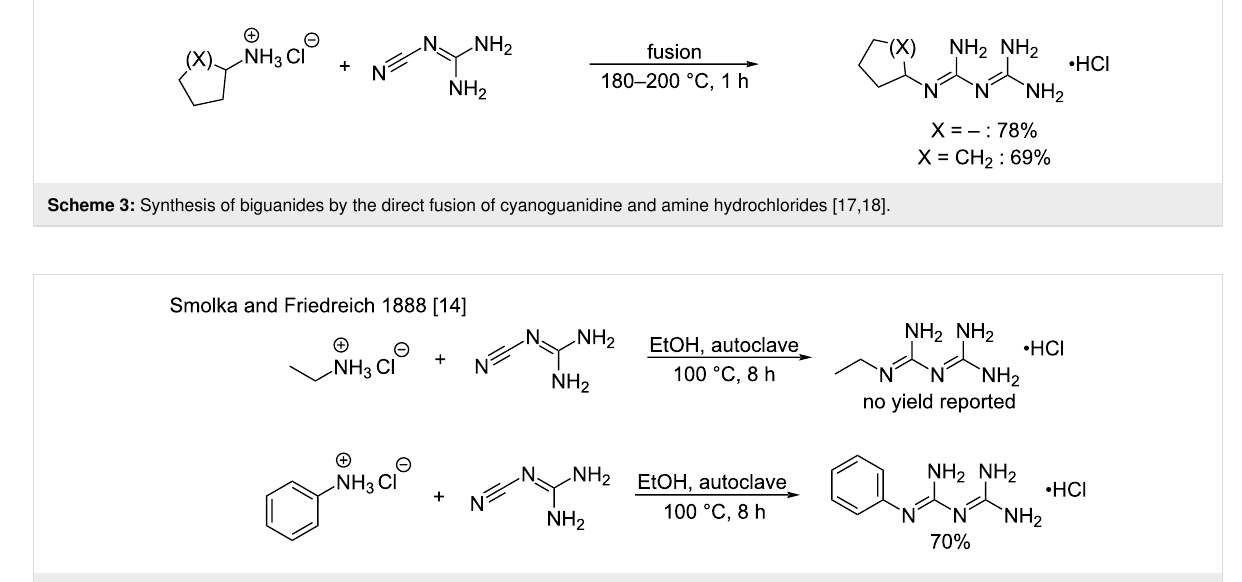
Scheme 4: Synthesis of ethylbiguanide and phenylbiguanide as reported by Smolka and Friedreich [14].